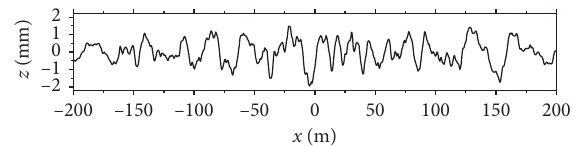
Figure 2: A stochastic sample of wheel/rail irregularities of the Beijing Urban Rail Line